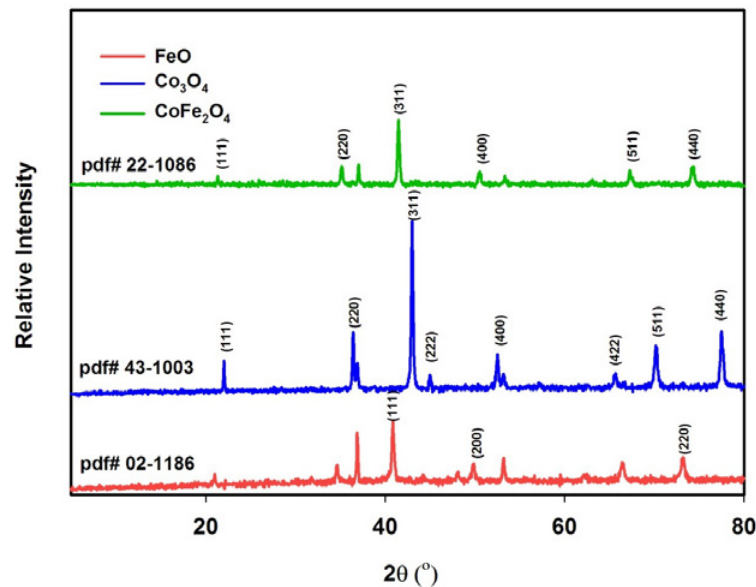
Fig. 4.XRD patterns of cobalt oxide, iron oxide, cobalt ferrite nanoparticles prepared by wet chemical route after